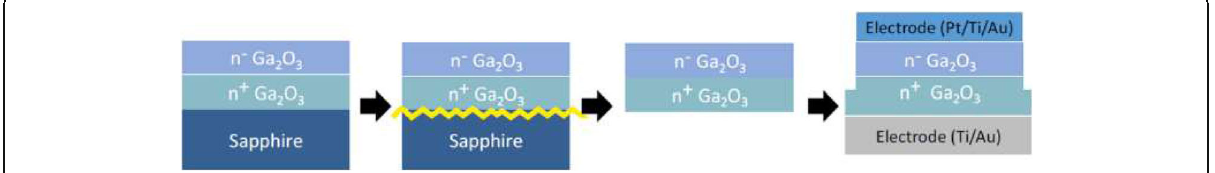
Fig. 8 Fabrication processes of the α -Ga 2 O 3 SBD proposed by FLOSFIA Inc. Reprinted from ref. [18,